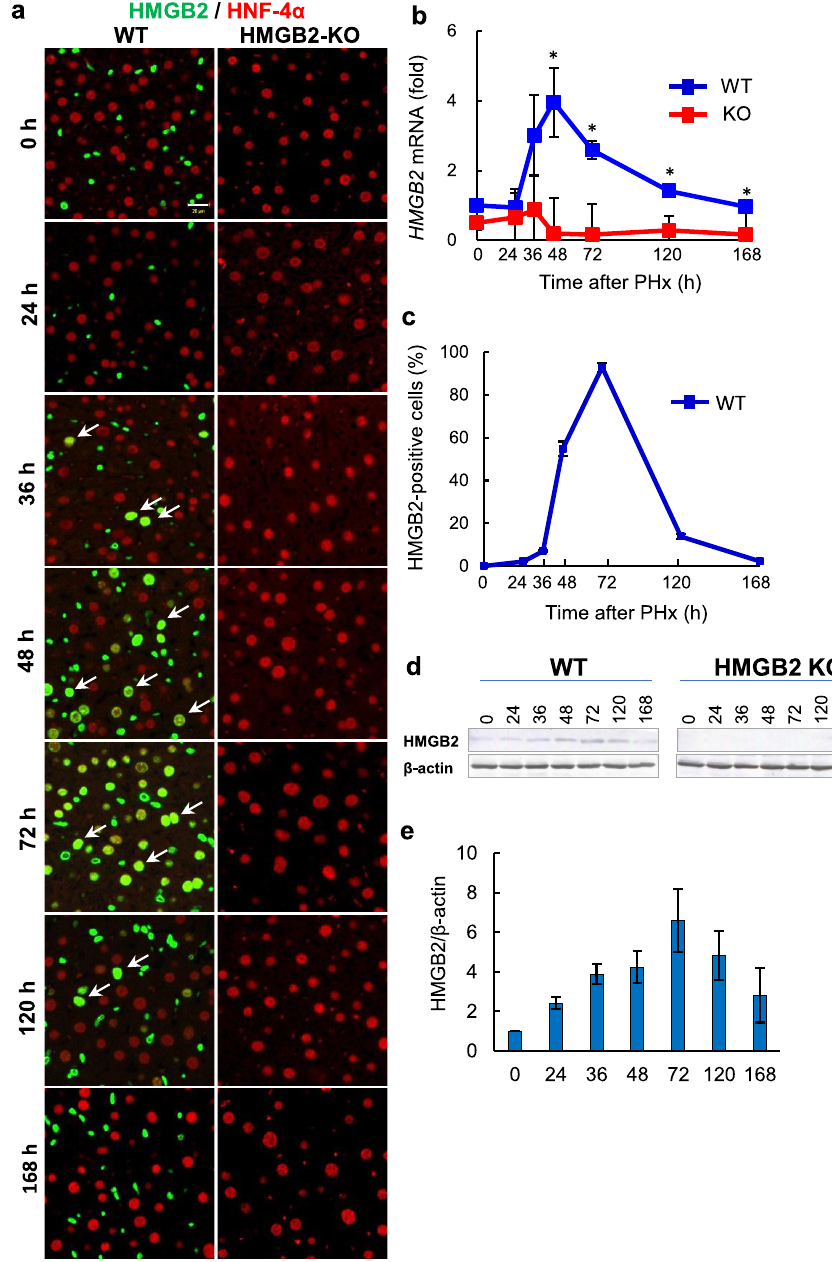
Figure 2. Expression of HMGB2 in mouse liver during regeneration. ( a ) Double immunofluorescence for HMGB2 (green) and HNF-4α (red) in WT and HMGB2-KO mouse livers after PHx. Arrows indicate HMGB2- positive hepatocytes. Scale bar 20 μm. ( b ) qPCR analysis of HMGB2 mRNA during liver regeneration. ( c ) The number of HMGB2-positive hepatocytes was counted at each time-point after PHx. Data represent the mean ± SEM from 5–6 mice per group. ( d ) Western blotting of HMGB2 in WT and HMGB2-KO mouse livers after PHx. ( e ) Densitometry analysis of HMGB2 expression. Data represent the mean ± SEM from 3 mice per group. Asterisks indicate statistically significant differences (* p <